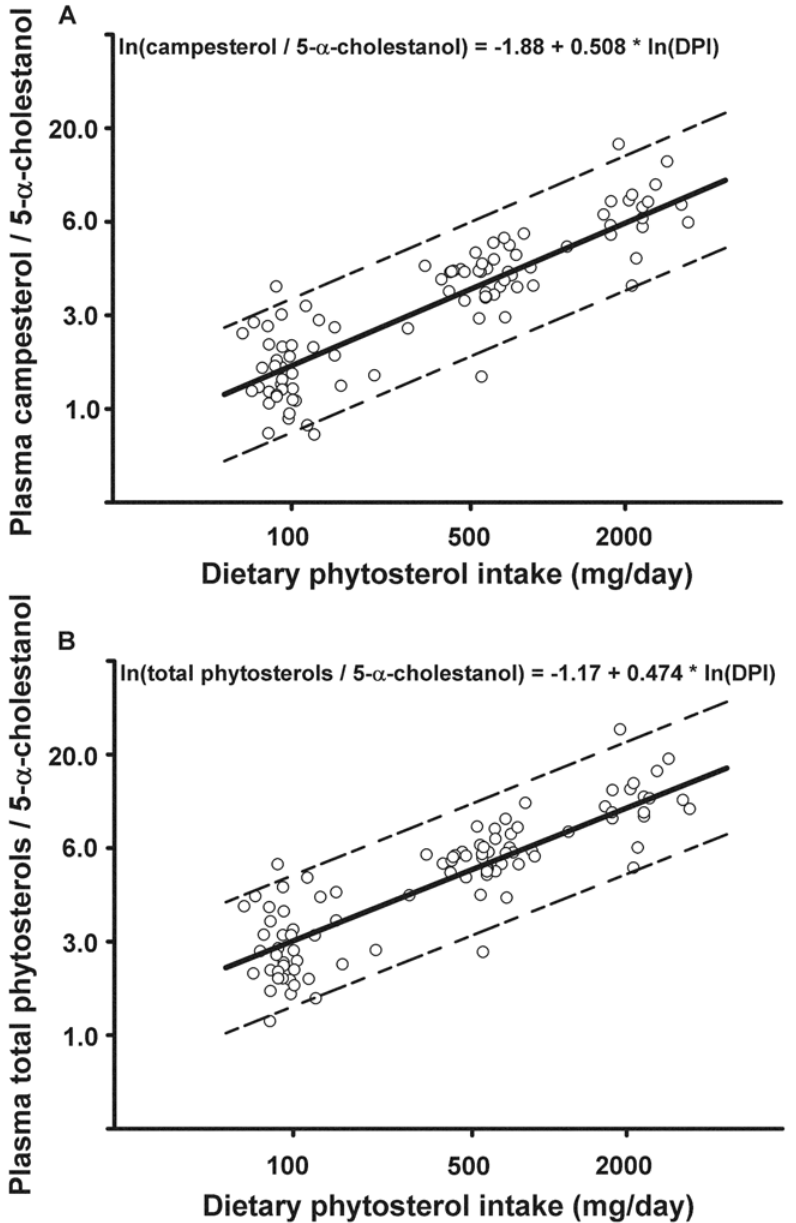
Fig 4. Regression of plasma phytosterol levels normalized by 5- α -cholestanol on dietary phytosterol intake (DPI). All values were transformed to natural log. Dotted lines represent 95% prediction limits of Ln (Campesterol/5- α -cholestanol) (A) and Ln(Total phytosterols/5- α -cholestanol) (B).